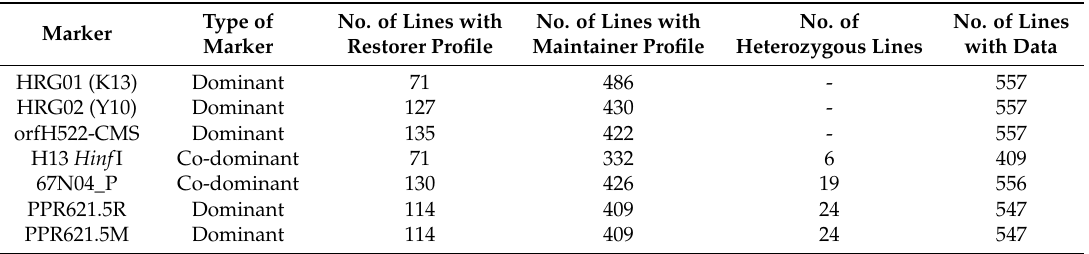
Table 6. Specificity of molecular markers used for detection of fertility restoration in the sunflower association